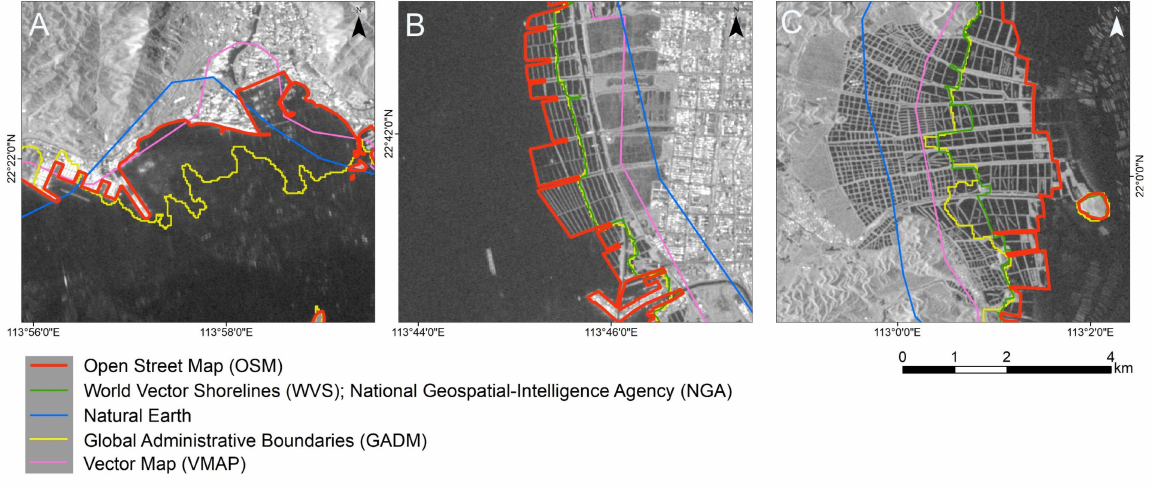
Figure 5. Comparison of coastline datasets for three coastal sections ( A – C ) along the shoreline in Guangdong Province, China. Background image: Median image derived from Sentinel-1